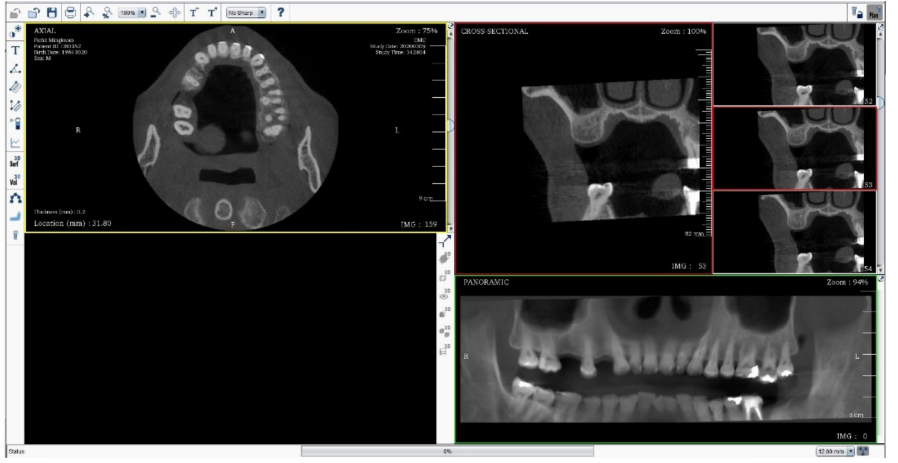
Figure 1. The full screen image capture of DentiPlan Pro version